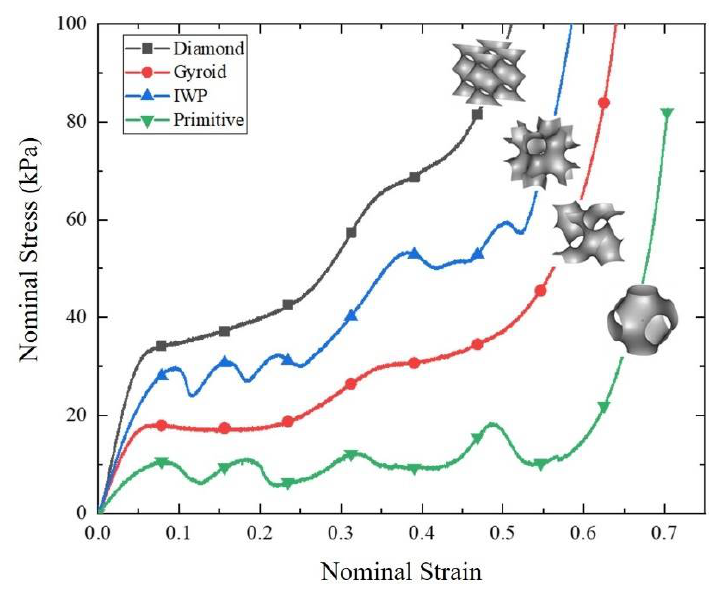
Figure 3. Nominal stress–nominal strain curves of four types of TPMS.